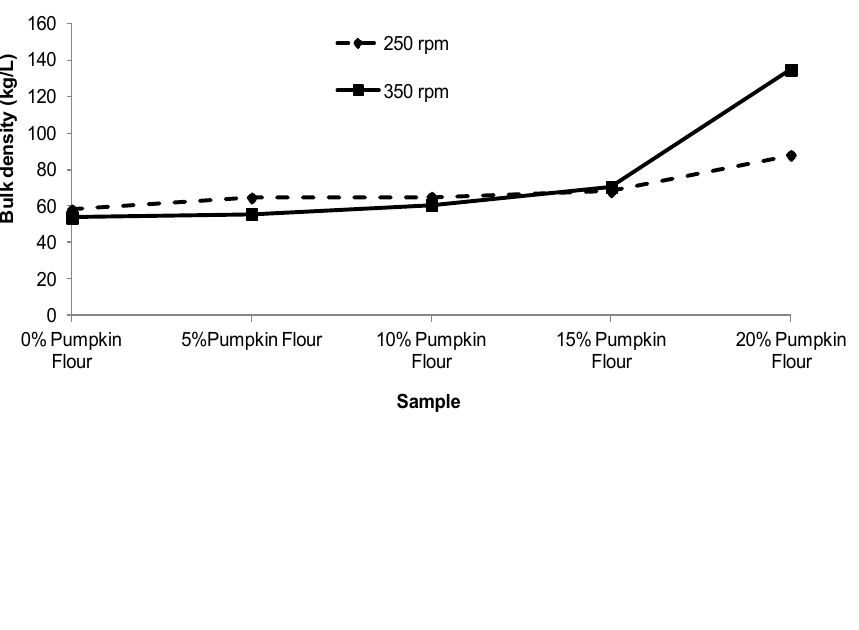
Figure 6. Effect of varying pumpkin flour percentage and screw speed on the bulk density of extruded product. Each value as an average of duplicate